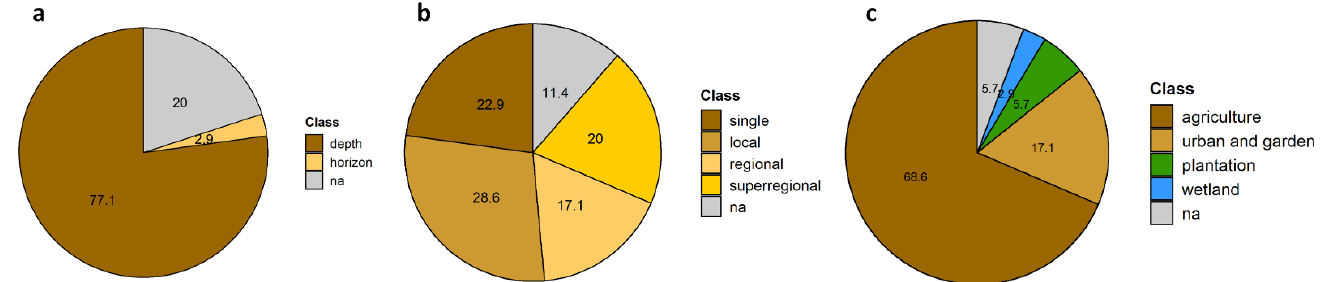
Figure 4. Documentation of depth sampling, lateral sampling scale and land use within the evalu- ated (n = 35) publications: ( a ) Depth sampling according soil horizons or metric depth scales (Table 1, 3-6) about the availability of the documentation (3-2). ( b ) Spatial scale of lateral sampling (Table 1, 3-8). ( c ) Major land use types documented (Table 1, 4-2).